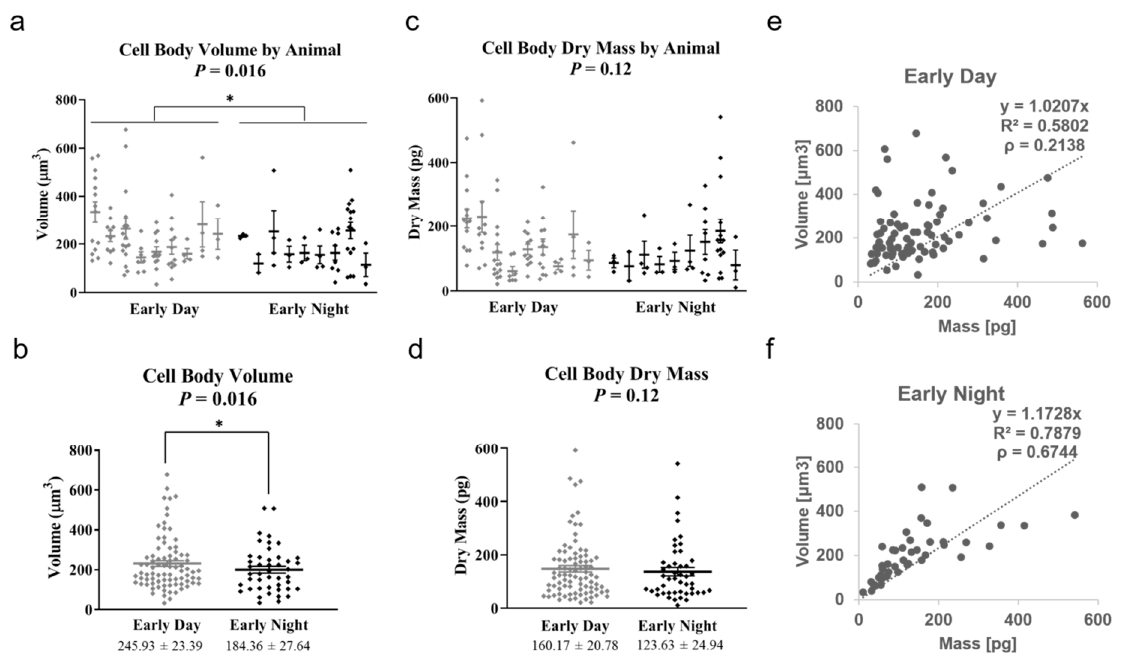
Figure 6. Astrocyte cell bodies display significantly larger volume during the day vs. night time. ( a ) Distribution of cell body volumes, with cells for individual animals shown as points on separate vertical lines. * p < 0.05 ( b ) Cell volume distribution obtained by combining measurements from all animals. The volume distributions for day vs. night show statistical significance. * p < 0.05 ( c ) Distribution of cell dry mass values, with cells for individual animals shown as points on separate vertical lines. ( d ) Cell dry mass distribution obtained by combining measurements from all animals. The dry mass distributions for day vs. night show no statistical significance. n = 9 animals per time point (total of 129 cells). Error bars represent standard error of the mean (SEM). ( e , f ) show that the correlation between dry mass and volume is more pronounced during the early night ( f ).